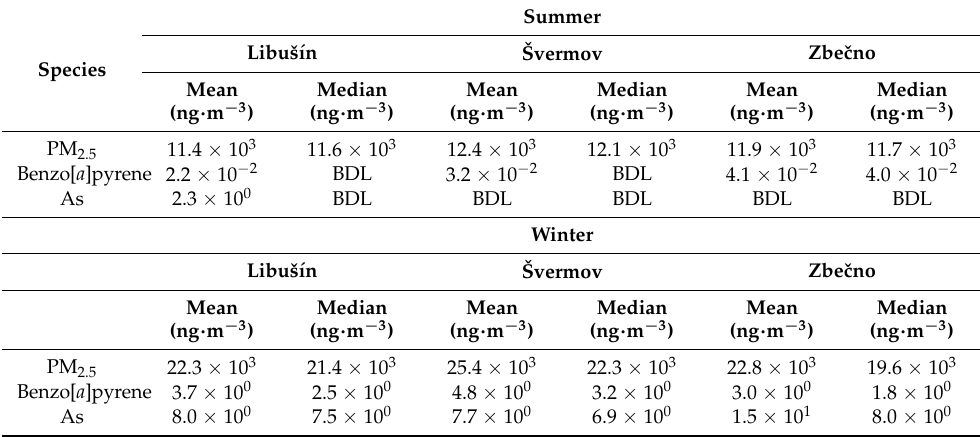
Table 2. Mean and median concentrations of selected species. BDL: Below the detection limit.